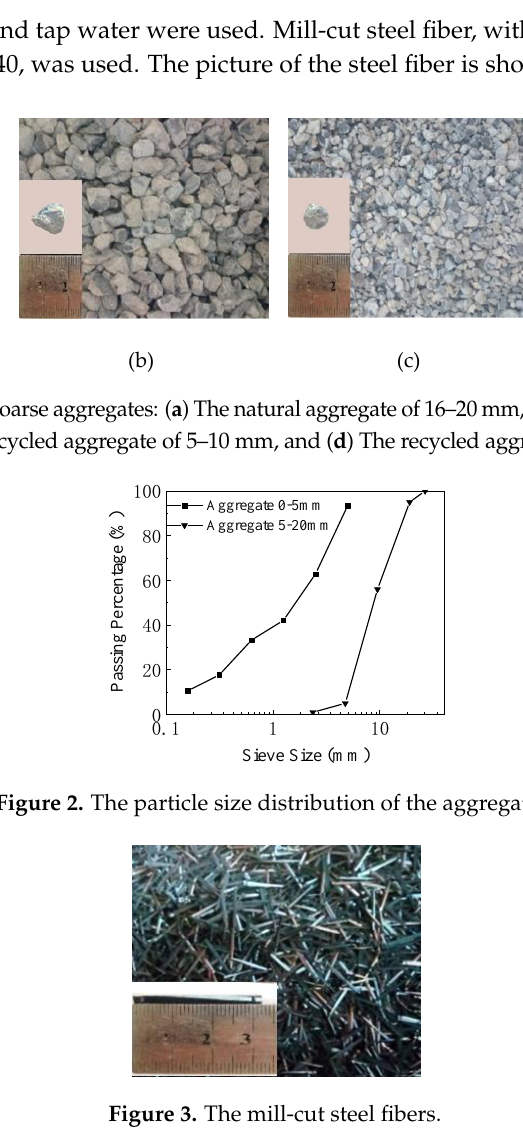
Table 1. The physical and mechanical properties of the fine and coarse aggregates.